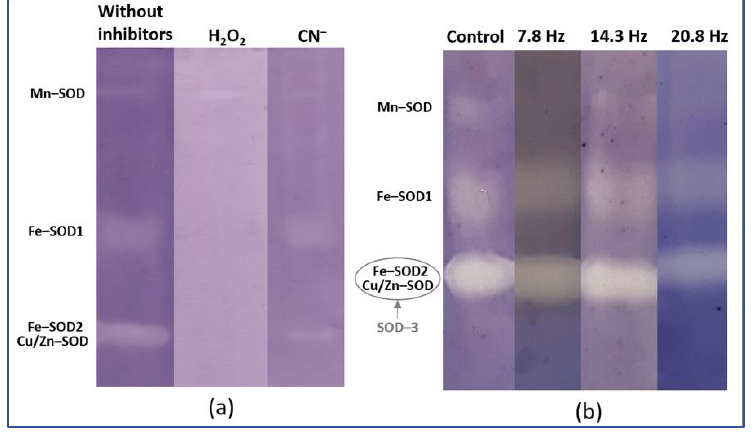
Figure 3. Isoenzyme activity patterns of SOD from wheat leaves: ( a ) inhibitory analysis of SOD; ( b ) typical pattern of the activity of SOD isoforms after exposure to ELF EMF of different frequencies. Table 2. Relative activity of superoxide dismutase isoforms in wheat and peas after short-time (30 min) and long-time (18 days) exposure to ELF EMF. Data are represented as mean ± SD.